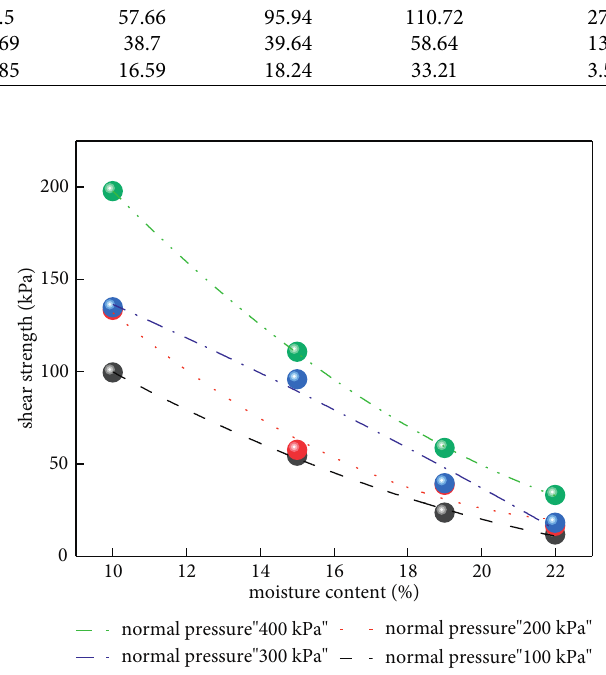
Figure 6: Relationship between shear strength and moisture content of silty clay. Table 7: Curve fitting parameters of the relationship between moisture content and shear strength under different normal pressure. Normal pressure (kPa)